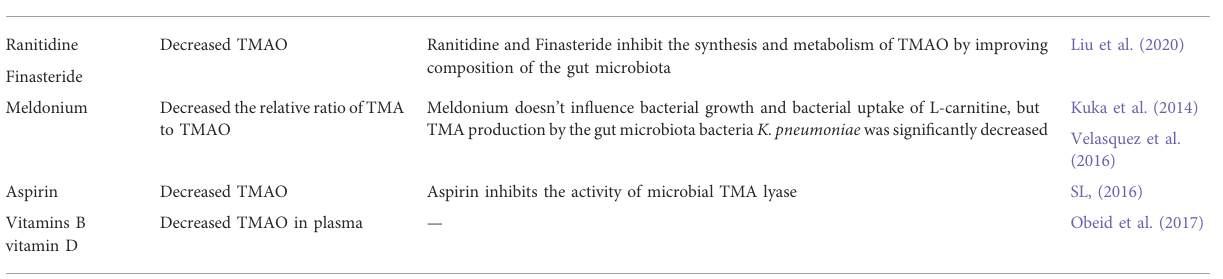
TABLE 5 Natural products that reduce TMAO